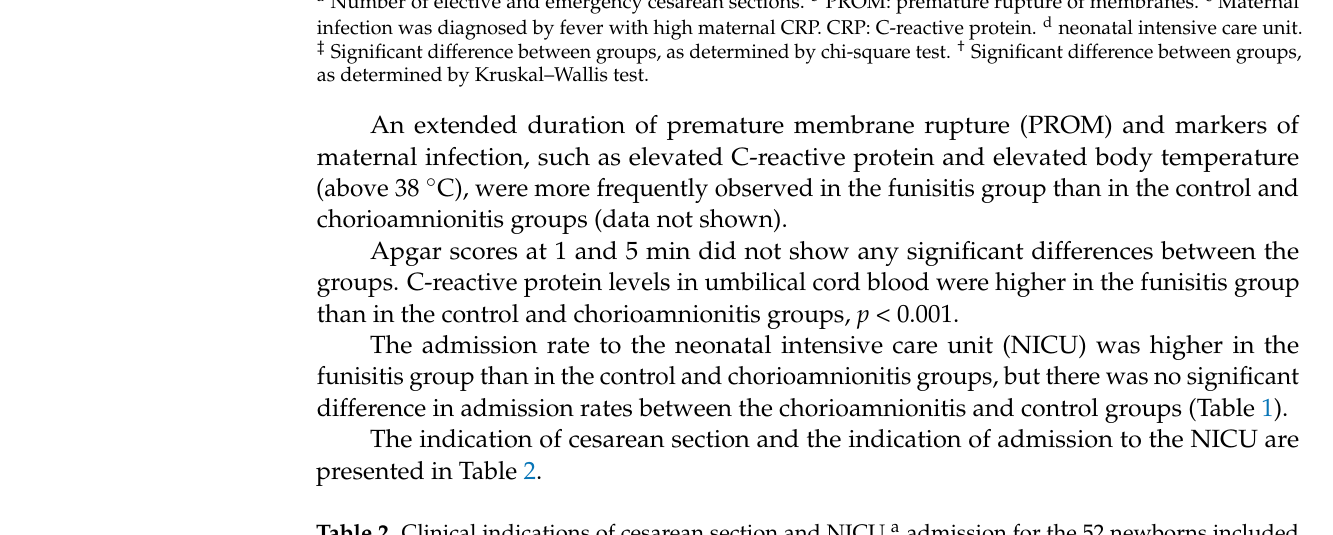
Table 2. Clinical indications of cesarean section and NICU a admission for the 52 newborns included in the